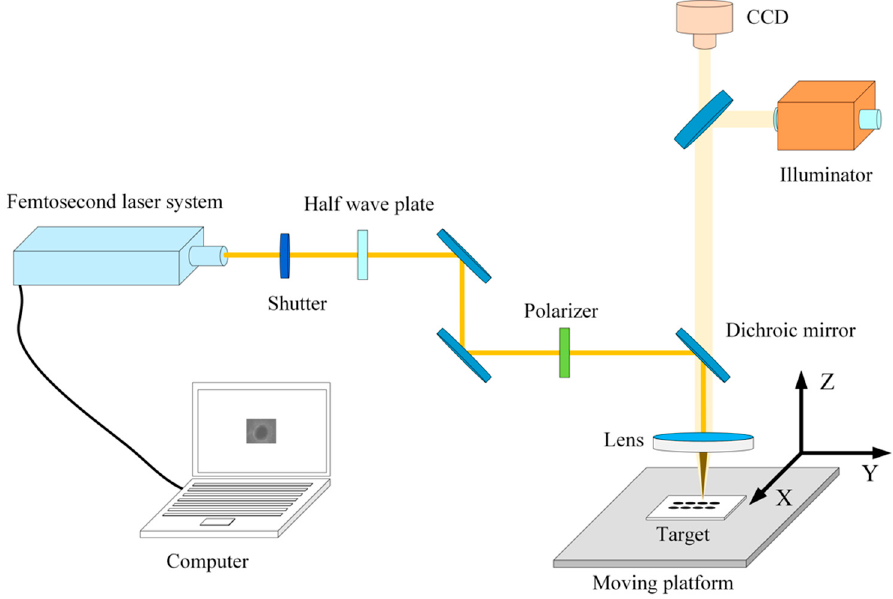
Figure 1. The schematic diagram of the experimental setup of the femtosecond laser percussion ablating.